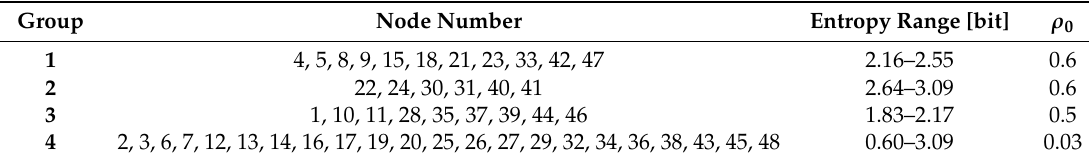
Table 4. Clustering results of 48 nodes.